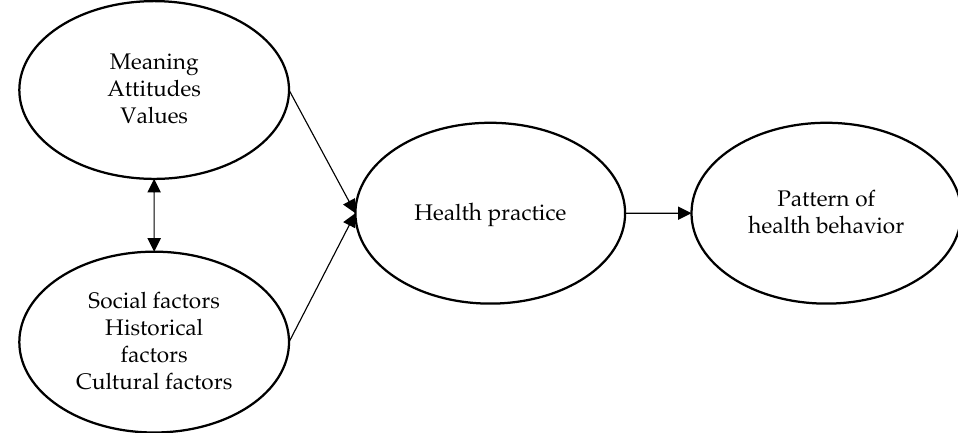
Figure 1. Lifestyle reading model proposed by the new